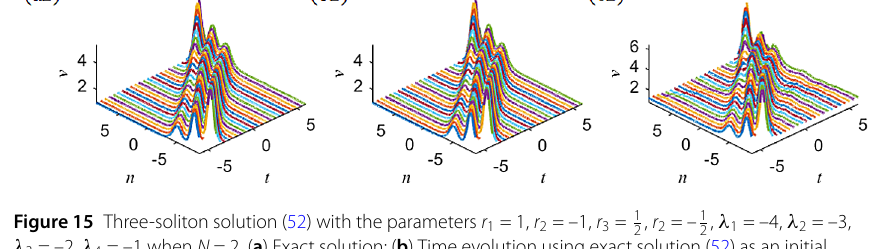
, r 2 = – 1 , λ 1 = –4, λ 2 = –3, 2 2